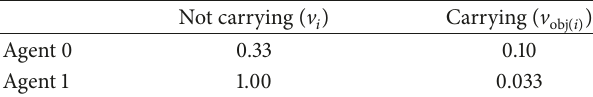
Figure 7: Simulation: two types of tasks by two types of robots. The field consists of 20 × 20 areas. The red circle and blue square represent the robots, the yellow squares represent objects to be carried, the white shading represents unvisited area, and the black shading represents visited area. Table 2: Moving speeds of each